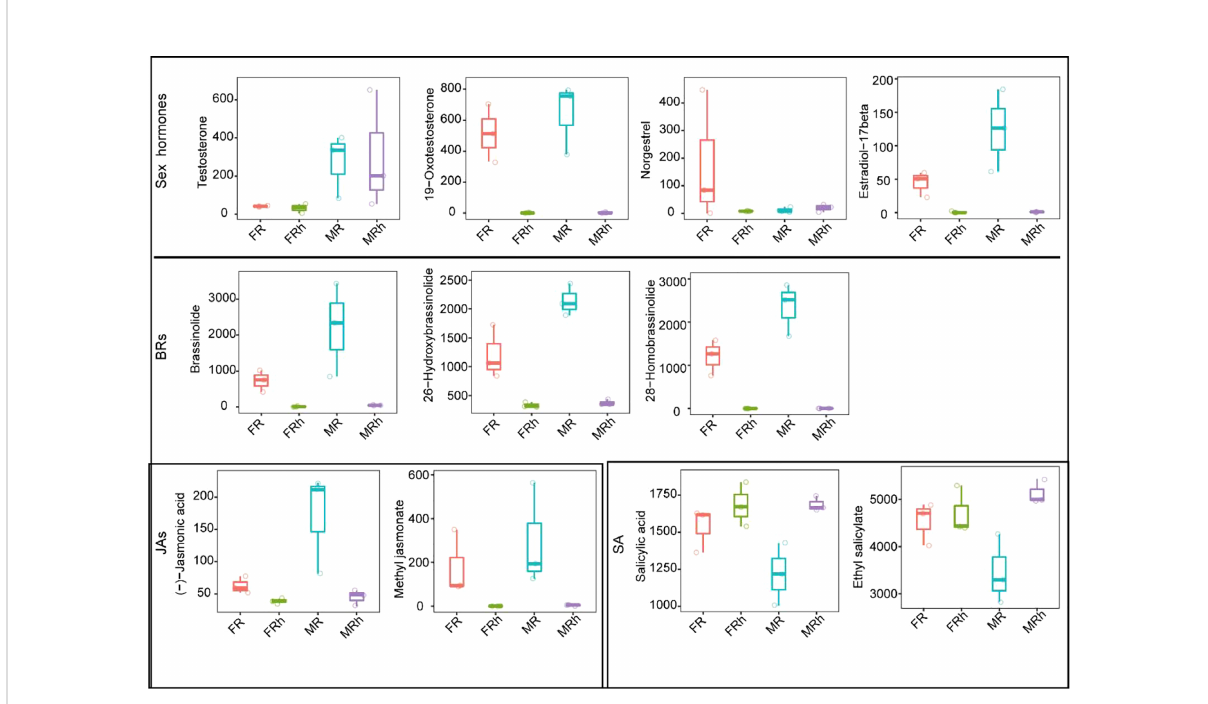
FIGURE 3 The compare analysis of hormone relative abundance in the roots and rhizosphere soils of